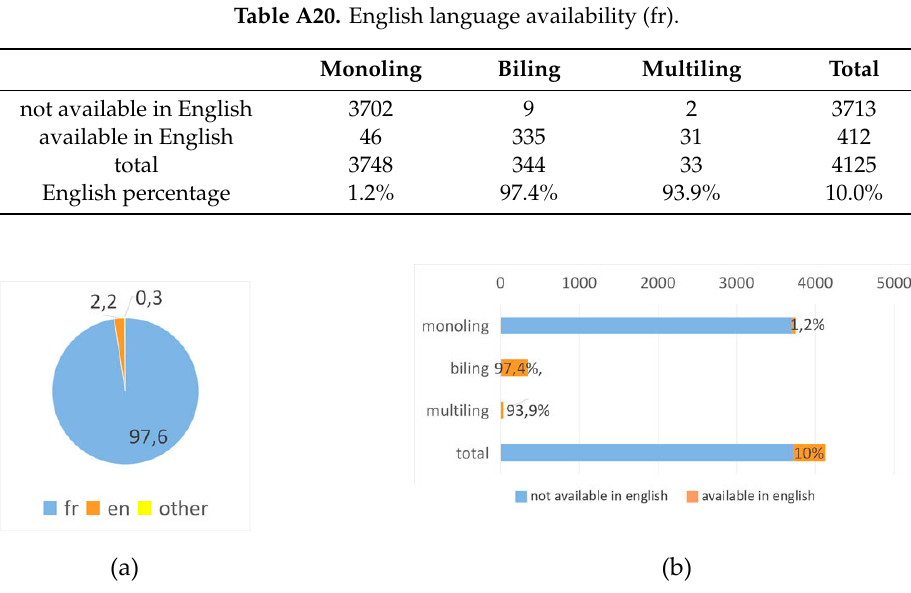
Figure A10. Visualization of the results for domain fr. ( a ) Primary languages pie chart and ( b ) English